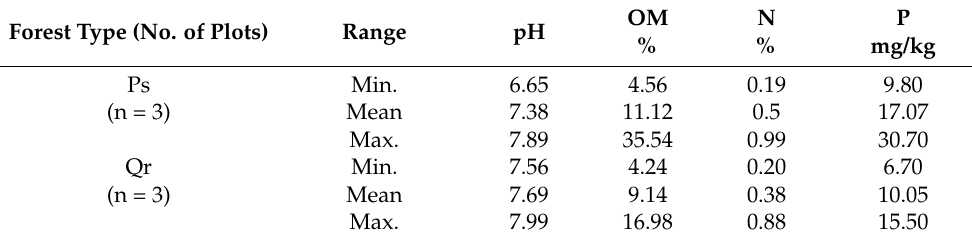
Figure 1. Boxplots of biomass of mycorrhizal and saprotrophic fungi (ppb) per three different soil layers (L = litter, H = humus, and Mn = mineral layer) for two different host species ( P. sylvestris and Q. robur ) in Mediterranean Spain. The asterisk over the boxplot indicates significant differences at α = 0.05 between soil layers. Table 1. Summary of the soil characteristics of the forest study: pH, organic matter (OM), Nitrogen (N) and phosphorus (P); n = 3: number of